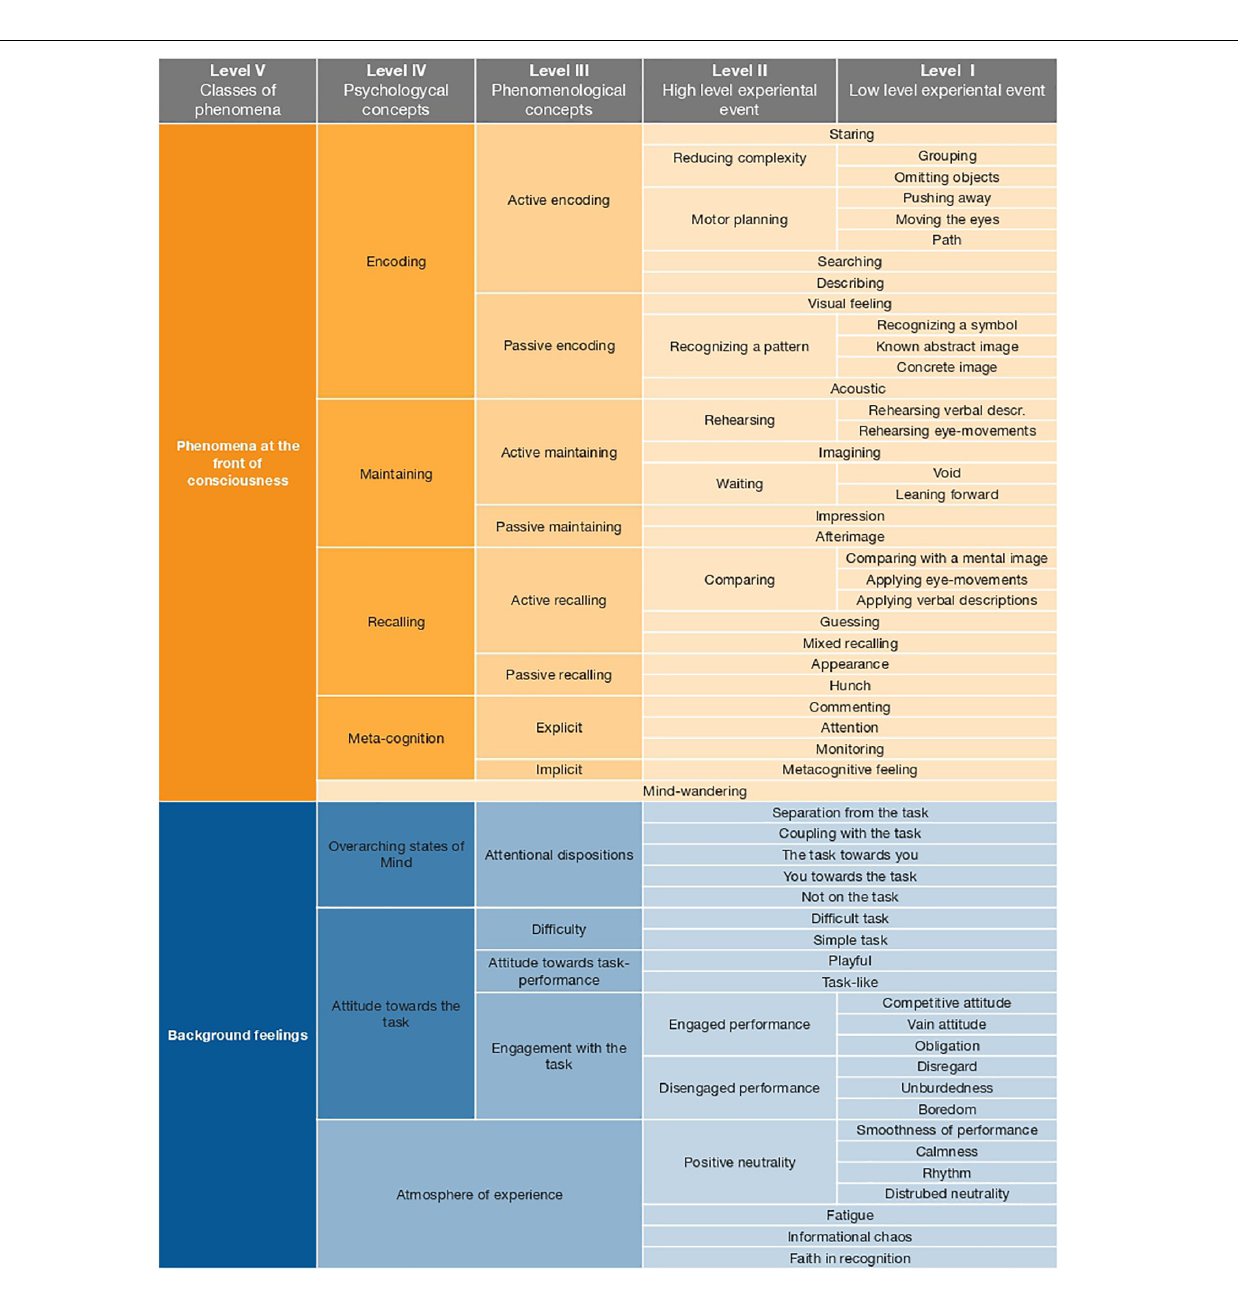
FIGURE 3 | Taxonomy of experiential categories. TABLE 1 | Condensed saturation